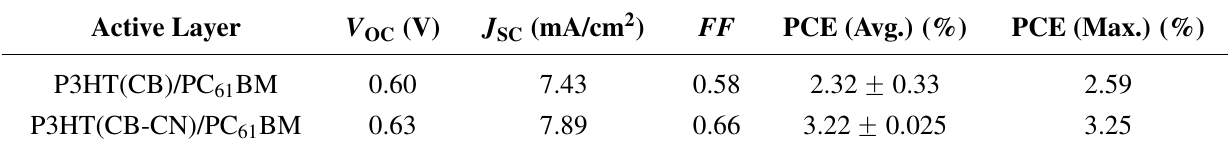
Figure 5. ( a ) Current density ( J ) vs. voltage ( V ) curves of bilayer OPVs based on the P3HT/PC 61 BM bilayers with a different P3HT bottom-layer and ( b ) their EQE spectra. ( c ) PCE of OPVs as a function of 1-CN concentration in P3HT solution. Table 3. Solar cell parameters of P3HT/PC 61 BM bilayer OPVs.